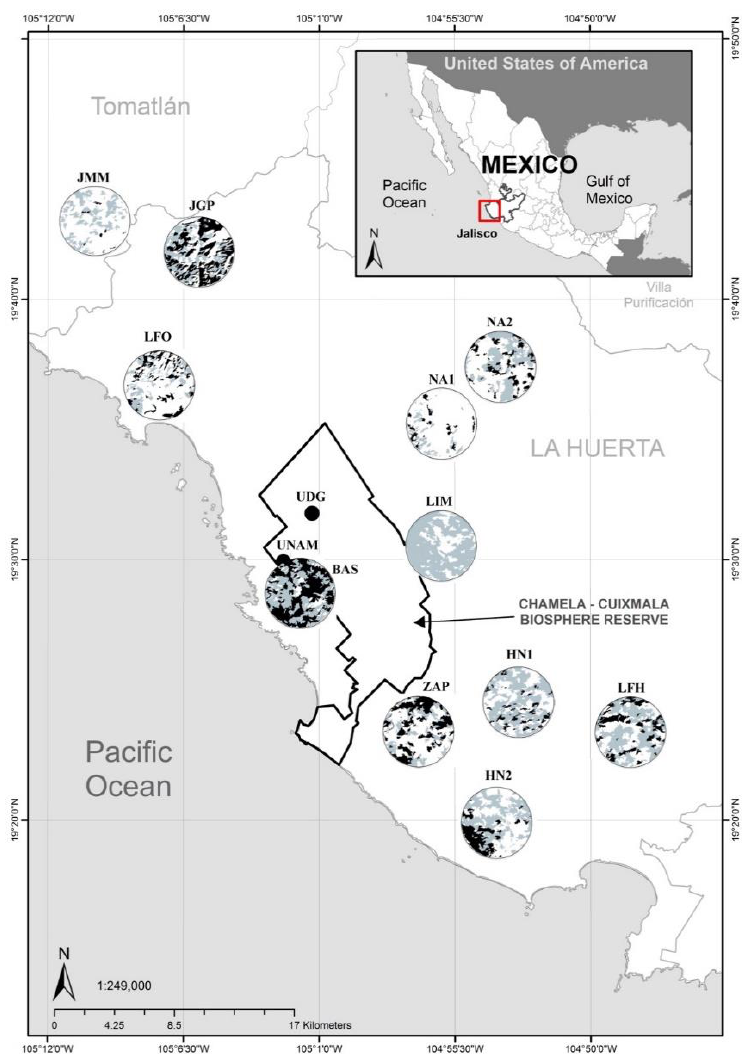
Figure 1. Study sites distribution along the pacific coast of Mexico. UNAM and UDG correspond to old growth forest, while other sites (JMM, JGP, LFO, NA2, NA1, LIM, BAS, HN1, ZAP, LFH, and HN2) correspond to early successional stages of the dry forest. The black polygon represents the Chamela-Cuixmala Biosphere Reserve limits and circles represent the maximum focal scale (3000 m) used for landscape characterization. Land-cover classes inside circles are as follows: (1) dry forest (gray), (2) riparian forest (black), and (3) other types of coverage